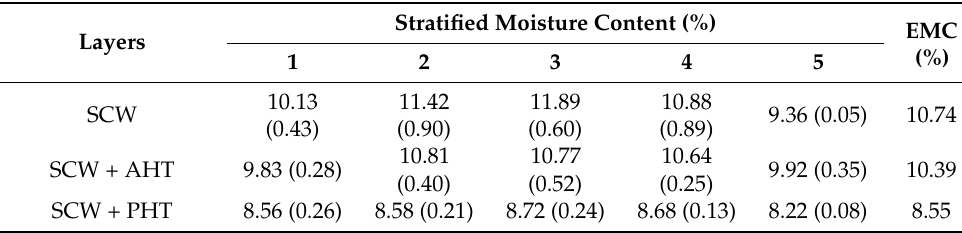
Table 1. Moisture content of SCW, SCW + AHT, and SCW + PHT. Layers